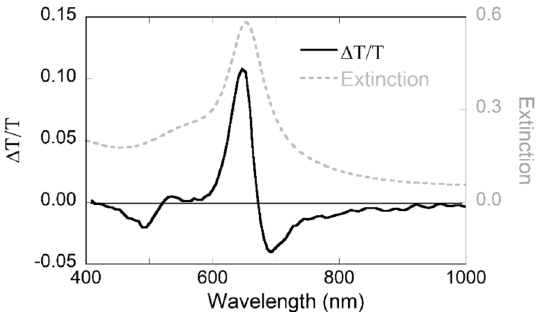
Figure 2. Transient transmission changes of Au nanoplates composite measured by ultrafast pump-probe spectroscopy. The grey dashed line represents the linear extinction spectrum extracted from Fig. 4a. for comparison.